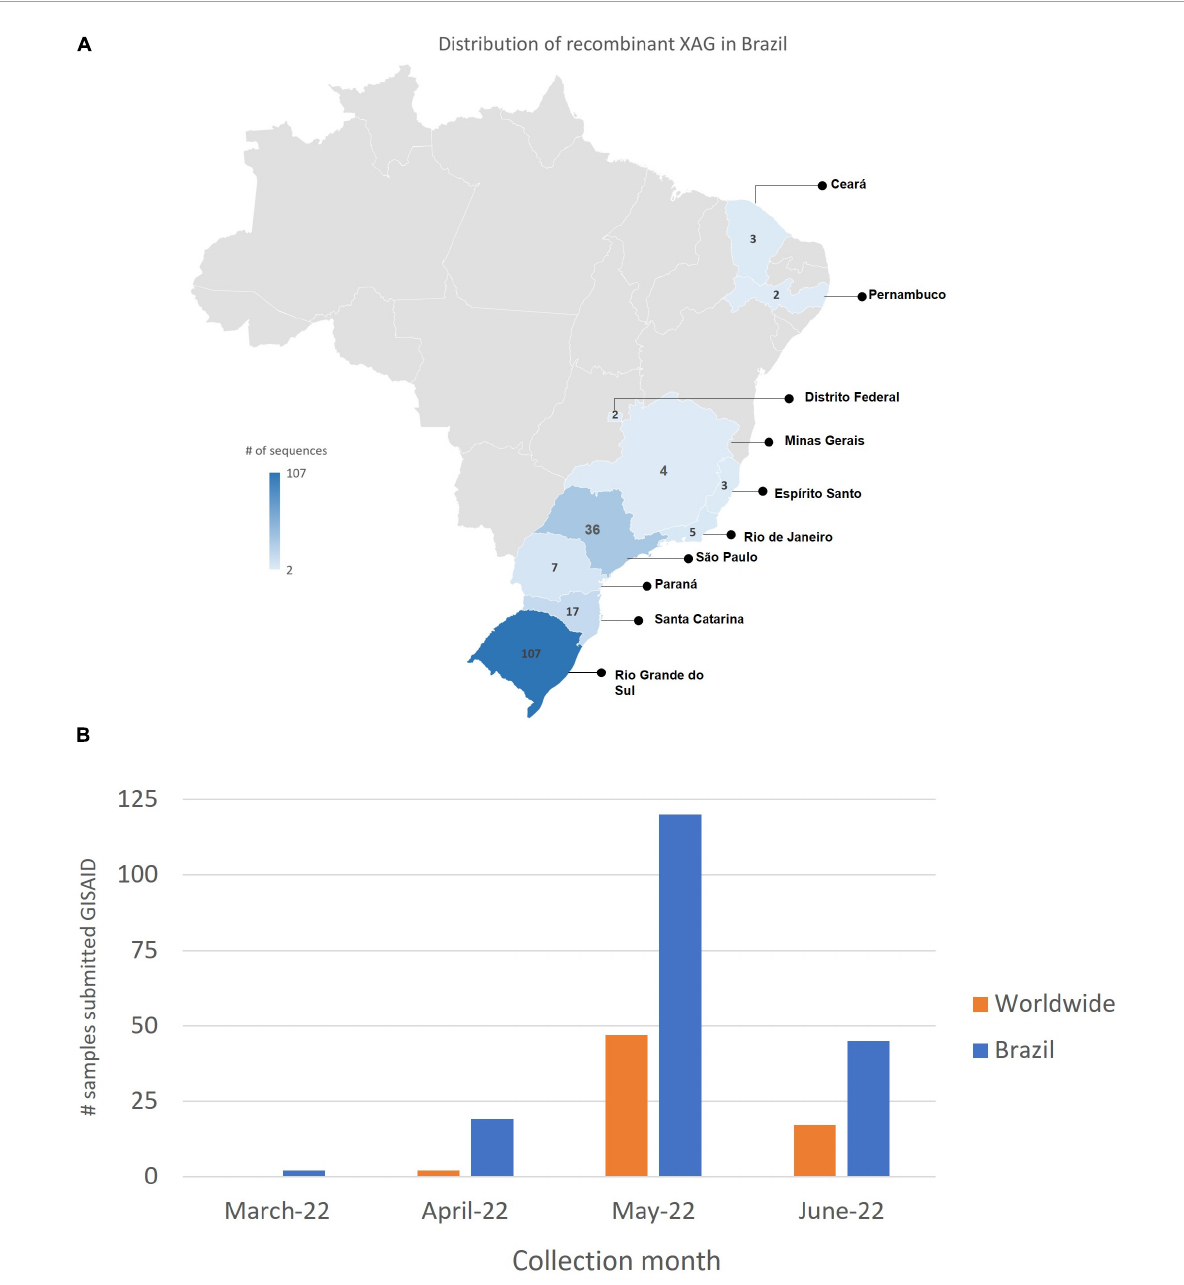
FIGURE2 Detection of recombinant XAG in Brazil. (A) Until June 2022, 186 sequences were detected in 10 states of Brazil: 107 sequences in Rio Grande do Sul (RS), 7 in Paraná (PR), 17 in Santa Catarina (SC), 34 in São Paulo (SP), 3 in Espírito Santo (ES), 2 in Minas Gerais (MG), 5 in Rio de Janeiro (RJ), 2 in Distrito Federal (DF), 2 in Pernambuco (PE), and 3 in Ceará (CE). The XAG recombinant was detected in other countries such as Argentina, Austria, Canada, Chile, Colombia, Denmark, France, Germany, India, Israel, Japan, Luxembourg, Mexico, New Zealand, Peru, Portugal, Scotland, Switzerland, and USA. (B) The number of XAG sequences submitted to GISAID between March and June in Brazil and worldwide.